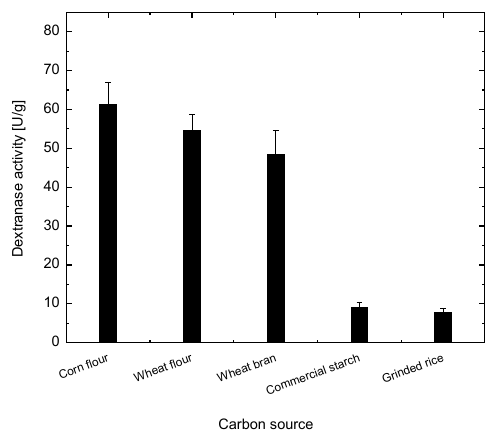
Figure 1. Effect of different starchy raw materials on dextranase production from Bacillus subtilis NRC-B233b